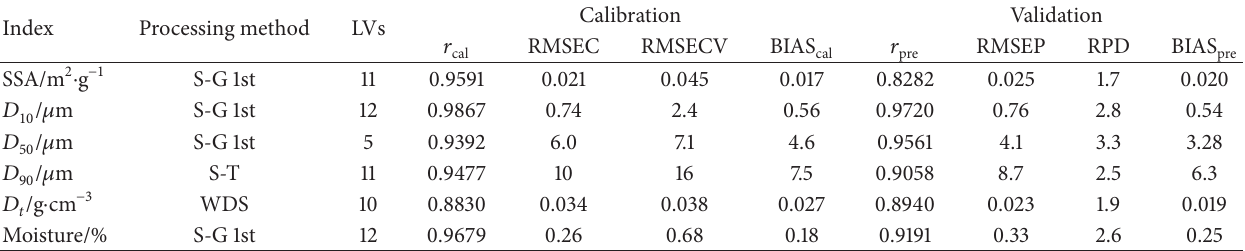
Table 8: The best preprocessing methods for near infrared spectra of partial least squares models of physical attributes.